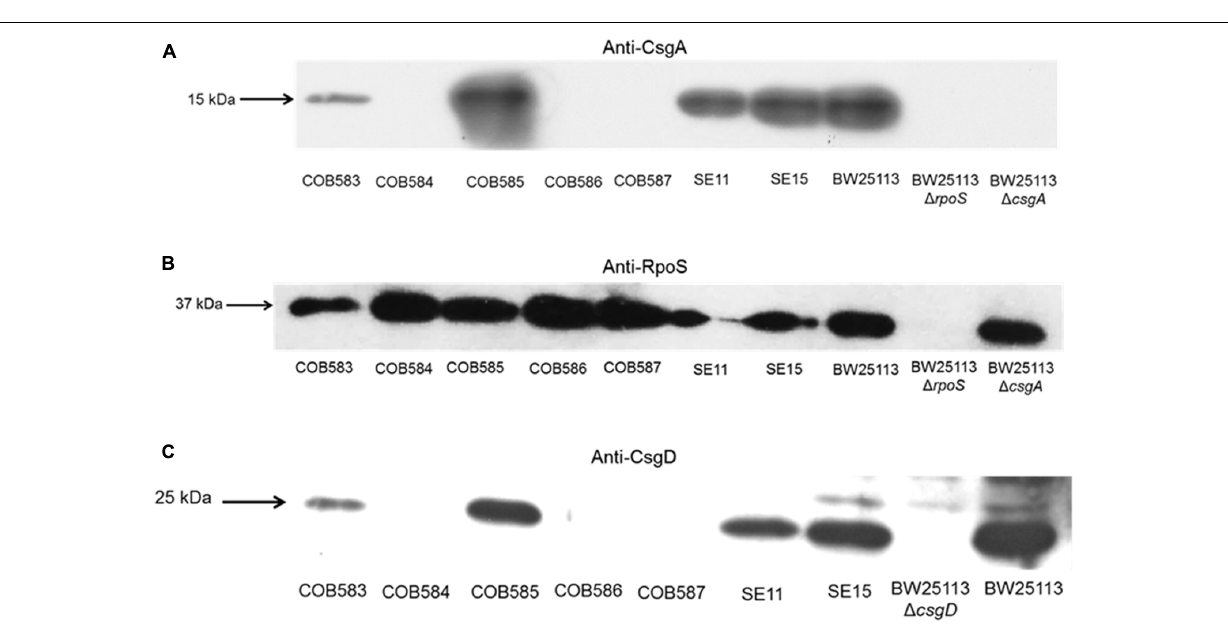
FIGURE 2 | CsgA and CsgD are not expressed in curli-negative soil-persistent Escherichia coli strains. Cells of soil-persistent, commensal and control strains were grown on Yeast Extract and Casamino acid (YESCA) agar at 28 ◦ C for 48 h. Protein extraction and western blotting was done for determining the expression of CsgA (A) , RpoS (B) , and CsgD (C)